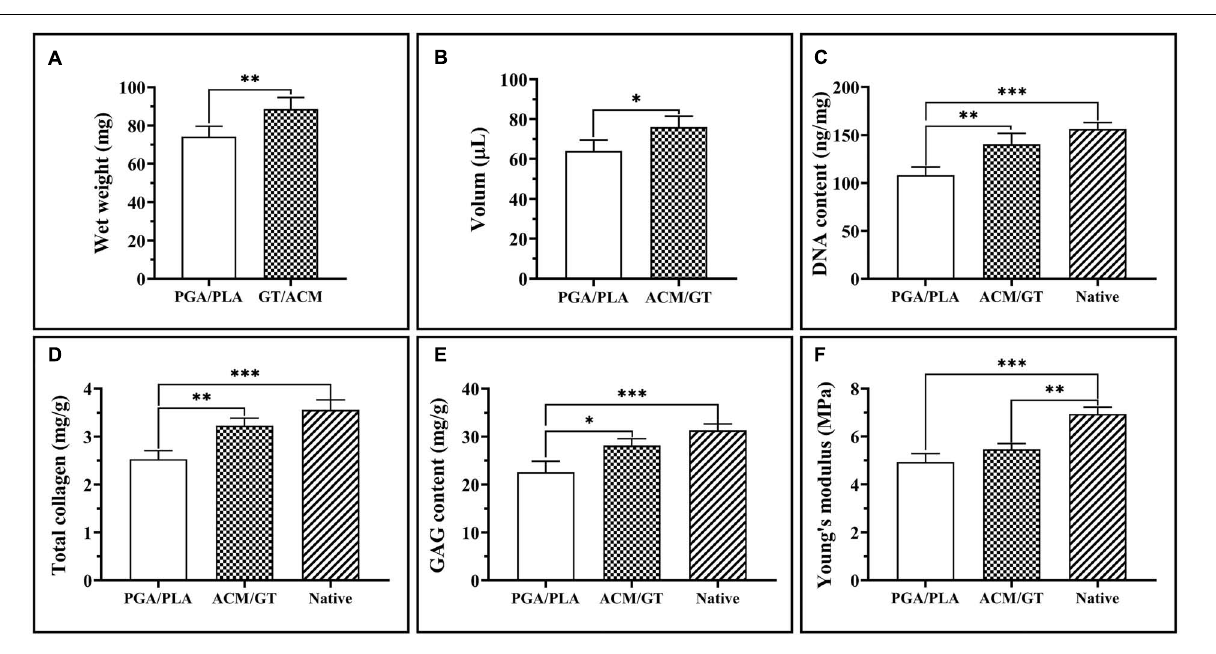
FIGURE 6 | Quantitative analysis of regenerated cartilage. The wet weight and volume of the regenerated cartilage-like tissues by the cell-PGA/PLA construct and cell-ACM/GT construct which subcutaneously implanted for 8 weeks (A,B) . The DNA content (C) , total collagen (D) , GAG content (E) , and Young’s modulus (F)